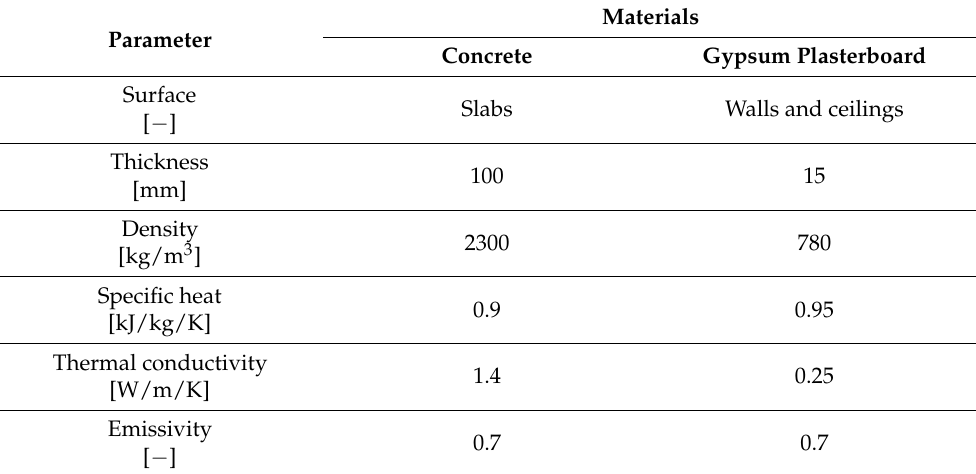
Table 2. Surface